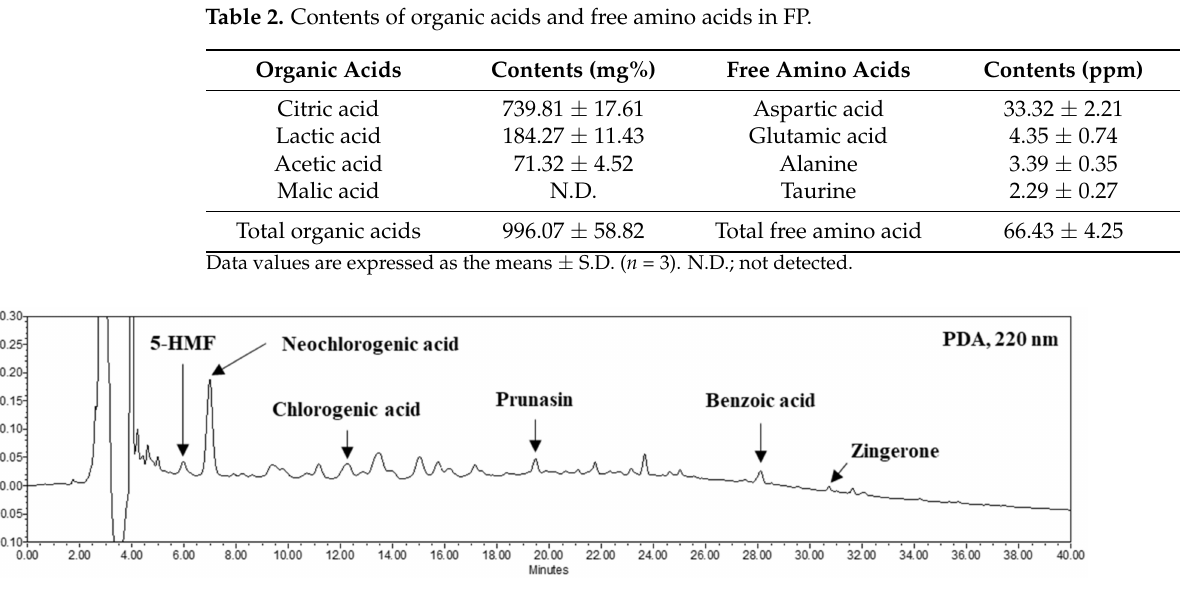
Figure 3. Phenolic compounds in FP analyzed by HPLC. 5-HMF (5.917 min); neochlorogenic acid (6.988 min); chlorogenic acid (12.244 min); prunasin (19.466 min); benzoic acid (28.093 min); zingerone (30.711